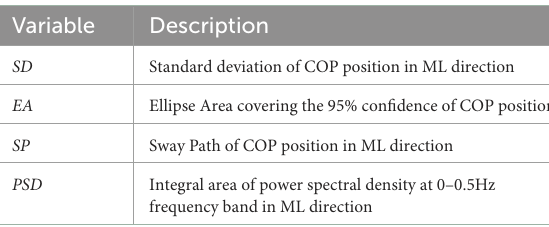
TABLE 3 Statistical results of posturographic variables between PD and MSA